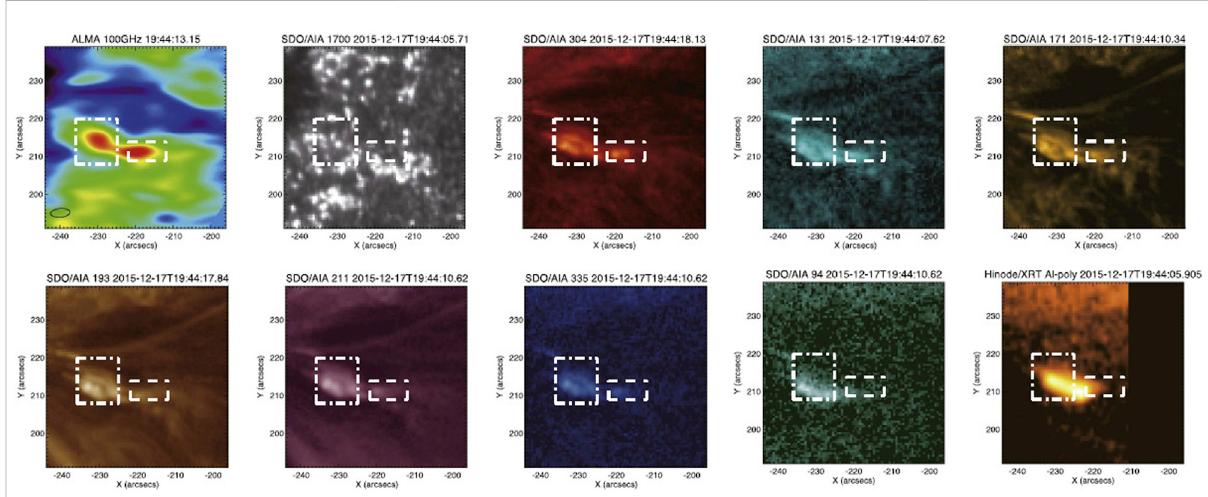
FIGURE 11 Images of a plasmoid ejection close to the time of its maximum emission. From left to right and top to bottom we present images at 3 mm (ALMA), 1700, 304, 131, 171, 193, 211, 335, and 94 Å (all from AIA), and Al-poly fi lter soft X-rays (from Hinode XRT) (from Shimojo et al., 2017b). © AAS. Reproduced with